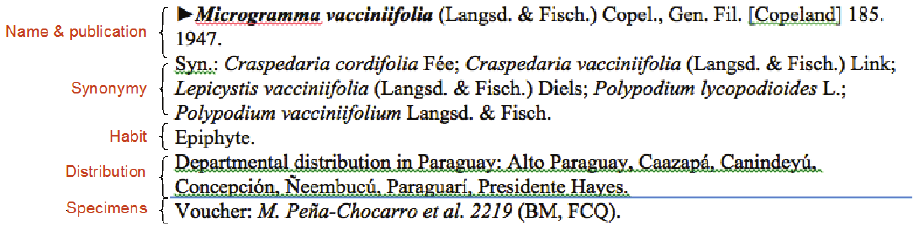
Figure 1. A typical species record from the